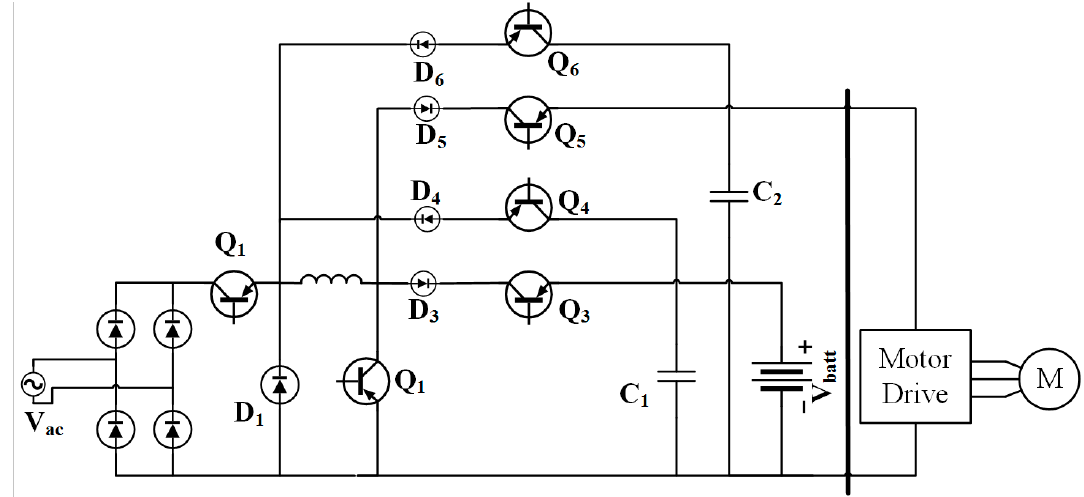
Figure 53. Integrated converter used in PHEV [35].